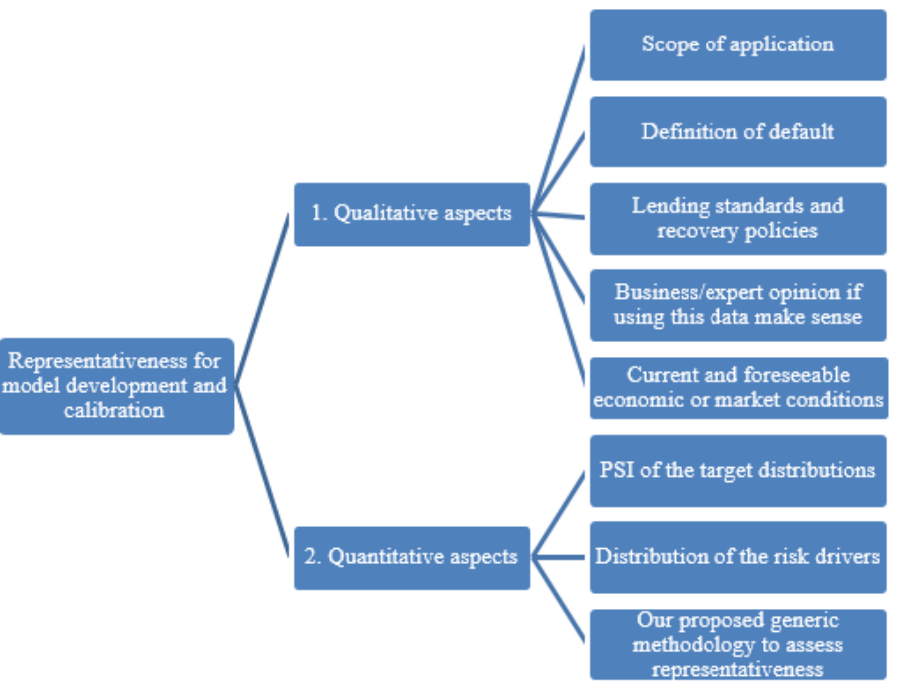
Figure 1. Tree-based diagram to define representativeness (across multiple dimensions).